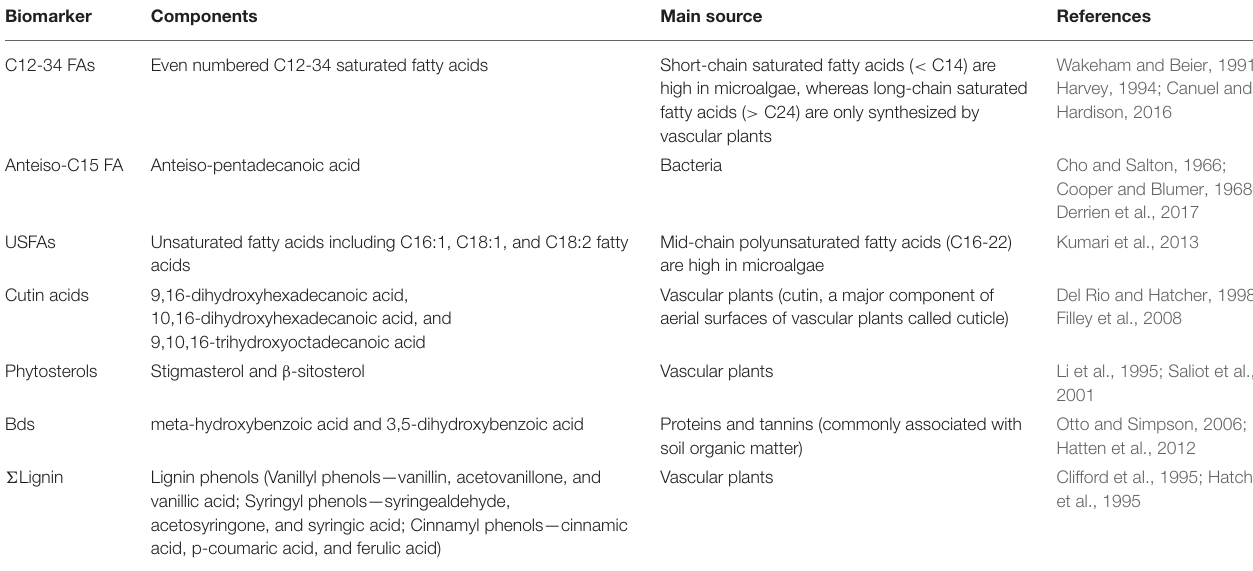
TABLE 2 | Biomarkers quantified in this